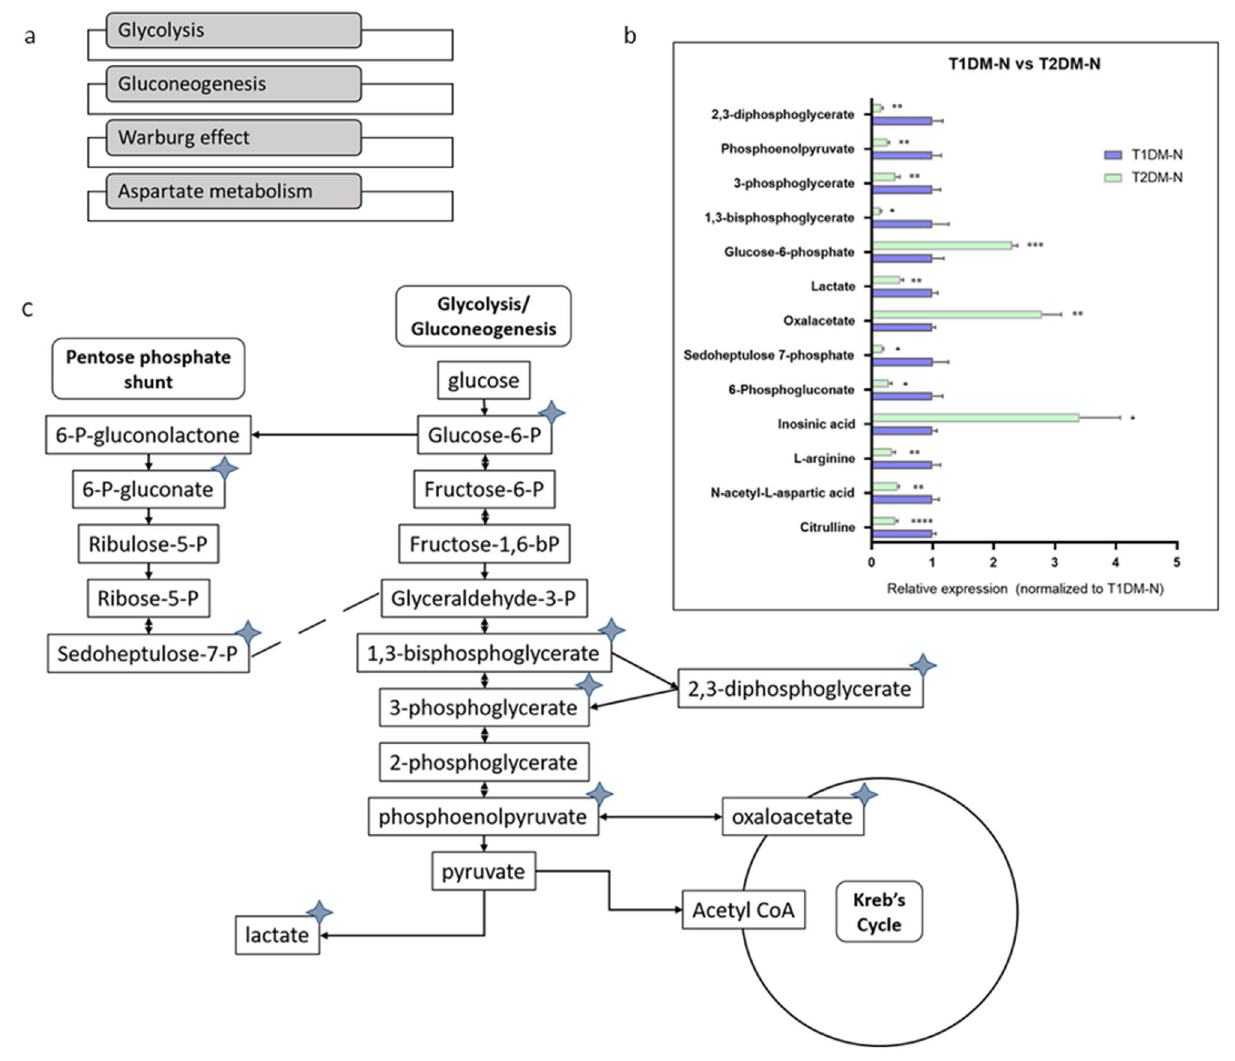
innervated constructs. ( C ) Representative diagram of significant metabolites (indicated in blue stars) on the main pathways involved in glucose metabolism. n = 3–4, student’s t test, p: *≤ 0.05; **≤ 0.01; ***≤ 0.001; ****≤